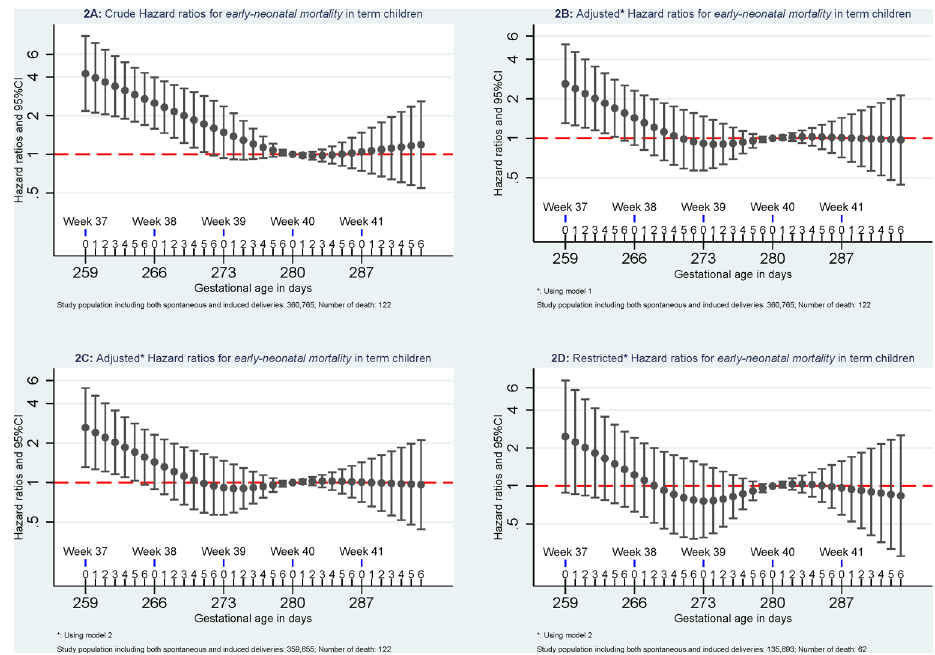
Fig 2. Hazard ratios for early neonatal mortality. Model 1: the results were adjusted for caesarean section (yes or no), maternal age ( < 25, 25 – 30, 30 – 35, > = 35), parity (1, 2, and 3), and birth year (1997 – 1999, 2000 – 2002, 2003 – 2005, and 2006 – 2008). Model 2, the results were additionally adjusted for maternal education (low, middle, and high) and maternal cohabitant status during birth (yes, no). Restricted analyses: the analyses were restricted to pregnancies without registered morbidity within one year before delivery or within 30 days after delivery using the same adjustments in Model 2.